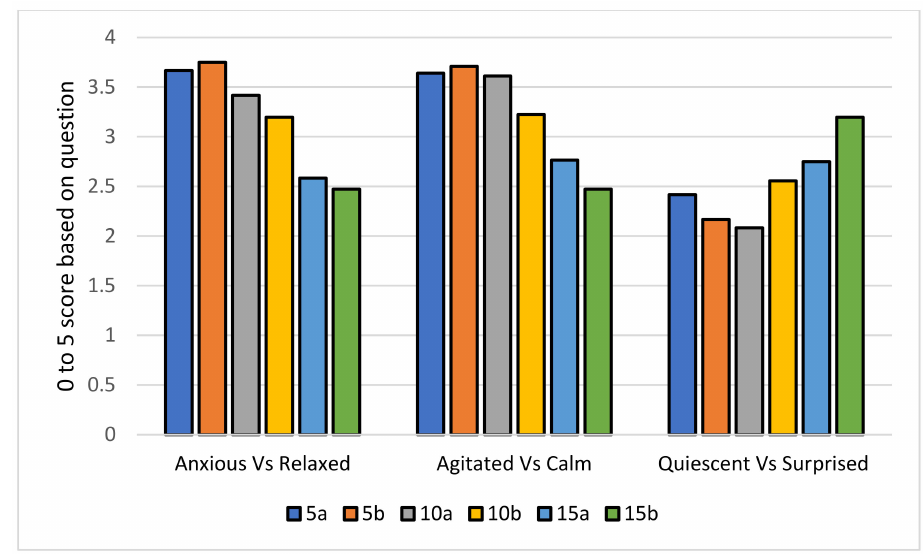
Figure 11. Self-reported feeling for safety for an overtaking vehicle session. At the end of the experiment, the Plutchiks wheel of emotions was used to assess participants’ overall feelings. Participants were instructed to choose five words to express their feelings. For an ego vehicle session, 60 words are chosen by 12 participants. Out of these words, only 17 words refer to negative feelings. Similarly, for an overtaking vehicle session, 60 words are chosen by 12 participants, with 21 referring to a negative feeling for the system. Most of the negative words chosen by the participants were anticipation for both an ego vehicle and overtaking vehicle session. Figure 12 shows the occurrence of negative word selection from the Plutchiks wheel of emotion chart.